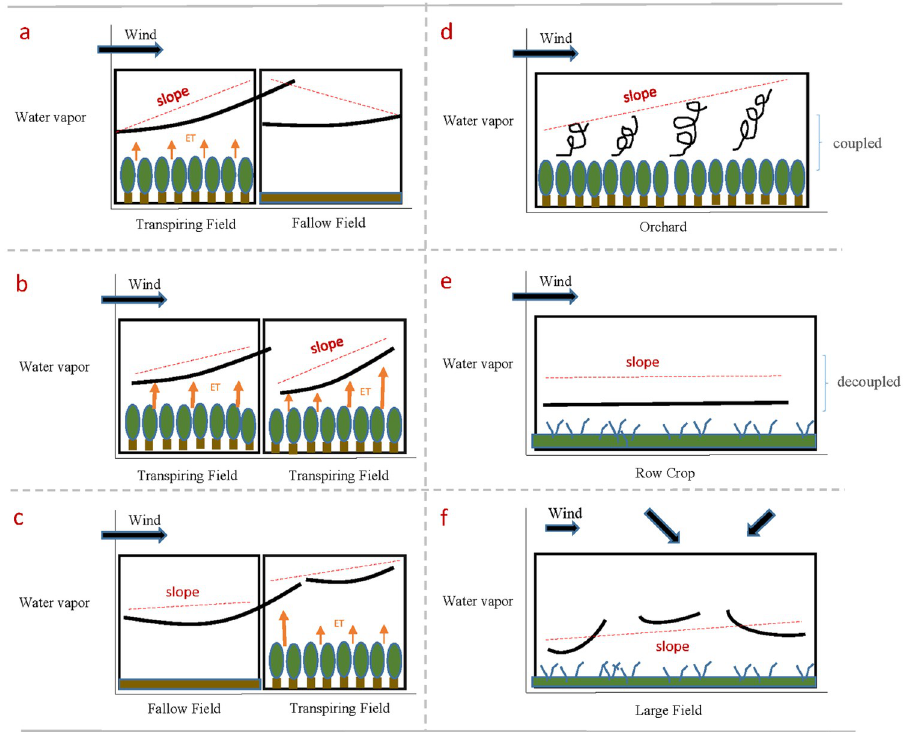
Fig 15. Field and canopy-level factors affecting water vapor trends. Schematic of water vapor over agricultural fields as it is affected by adjacent fields (A,B,C), as it changes with field roughness (D,E) and as it changes with wind heterogeneity (F). Black lines represent water vapor while red dotted lines indicate estimated